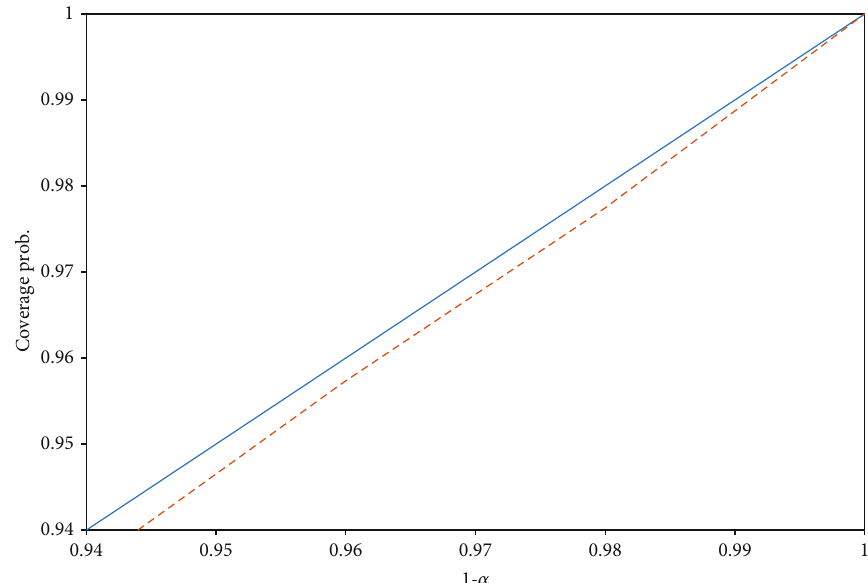
Figure 9: The conditional coverage probability of the estimative VaR forecast developed from two ARCH(1) processes; the estimated coverage (dashed red line) is quite close to the true coverage (solid blue